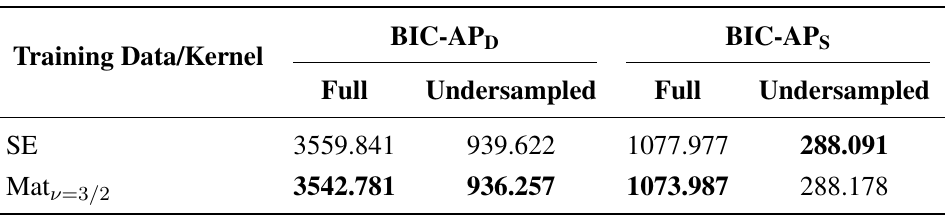
Table 5. Test error and BIC obtained from eight Gaussian process model fits with constant mean function. For each of the two kernels, the model was fitted either using the complete training data (full) or using only a subset of the training data (undersampled) for both access points. The lowest BIC is typeset in